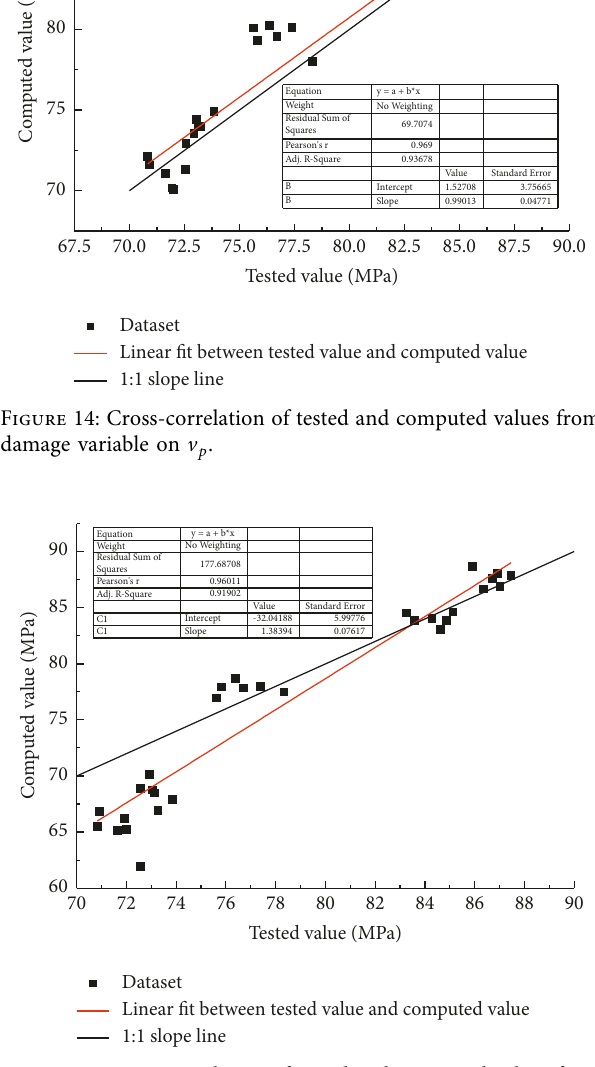
Figure 15: Cross-correlation of tested and computed values from damage variable on E